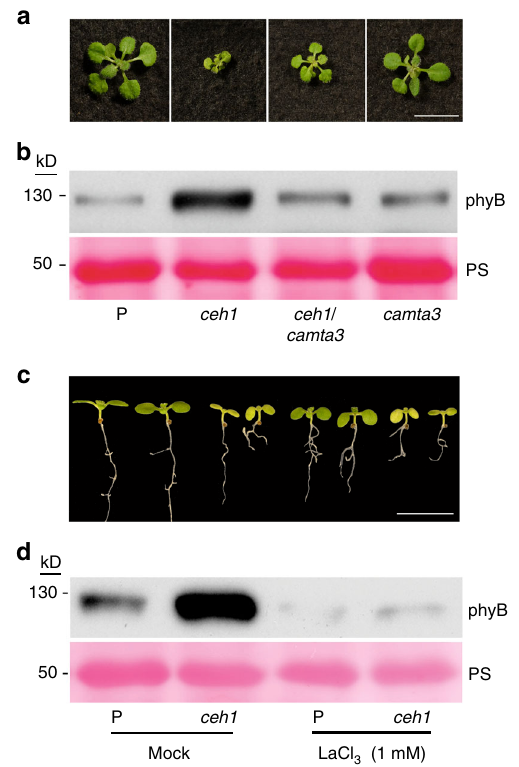
Fig. 7 PhyB protein abundance in ceh1 is CAMTA3- and Ca 2 + -dependent. Representative images ( a ) and phyB protein levels ( b ) in 7-day-old LD (16 h light/8 h dark) grown P, ceh1 , ceh1 / camta3 , and camta3 seedlings. Representative images ( c ) and phyB protein levels ( d ) in 7-day-old P and ceh1 seedlings in the absence (mock, 0.01% ethanol) and presence of LaCl respectively. Ponceau S (PS) staining was used as loading control.